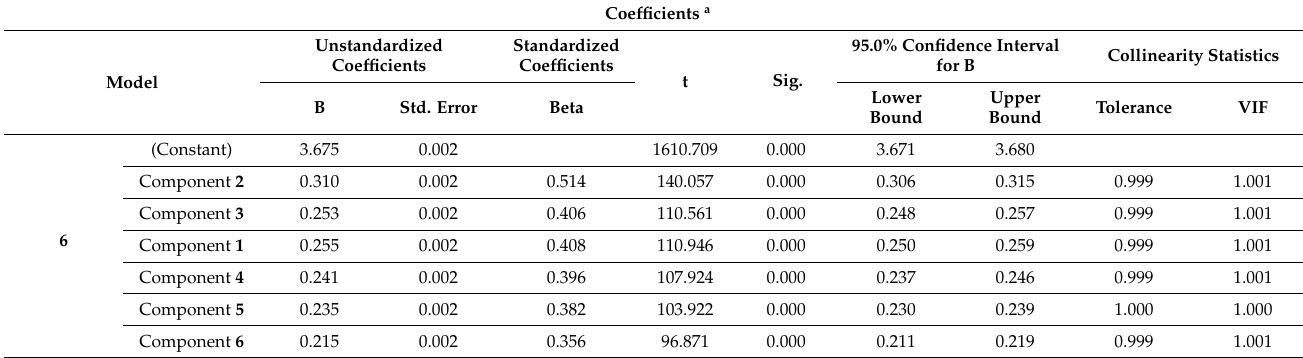
Table 8. Table of coefficients of components in multivariate linear model.